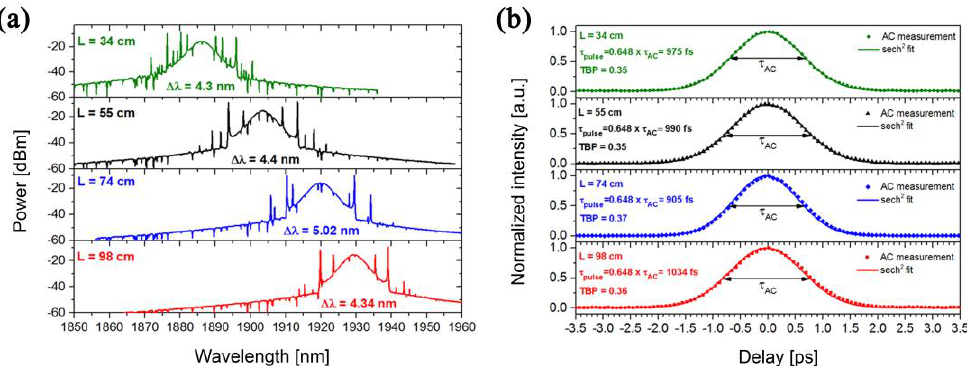
Figure 8. The optical spectra ( a ) and the autocorrelation traces ( b ) obtained in laser setups with different length of Tm-doped active optical fiber.